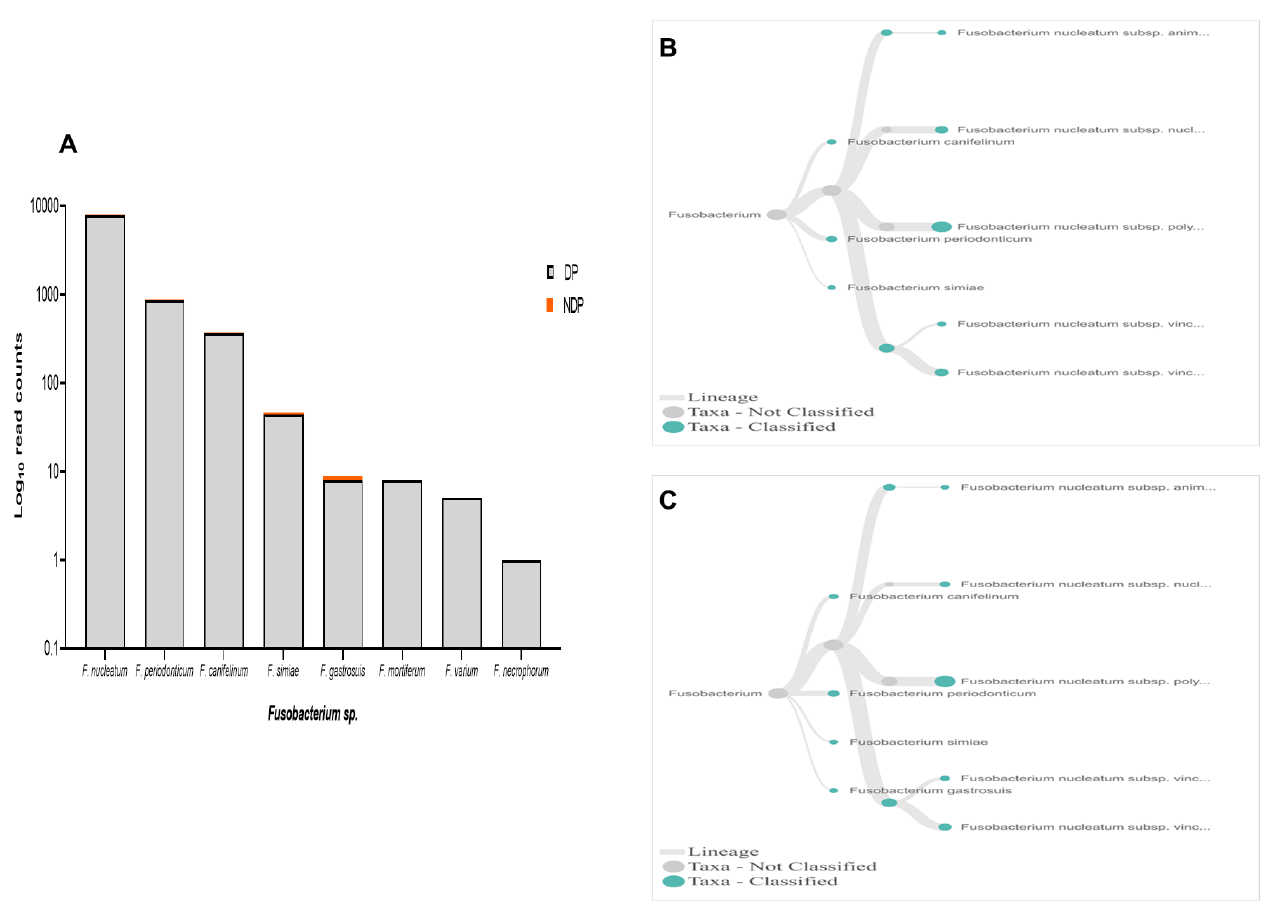
Figure 6. Fusobacterium sp. in pooled subgingival microbiota samples obtained from diabetic (DP) and non-diabetic (NDP) patients. ( A ) Abundance of Fusobacterium sp. ; ( B and C ) dendrograms showing the variability of Fusobacterium sp . in DP ( B ) and NDP ( C )